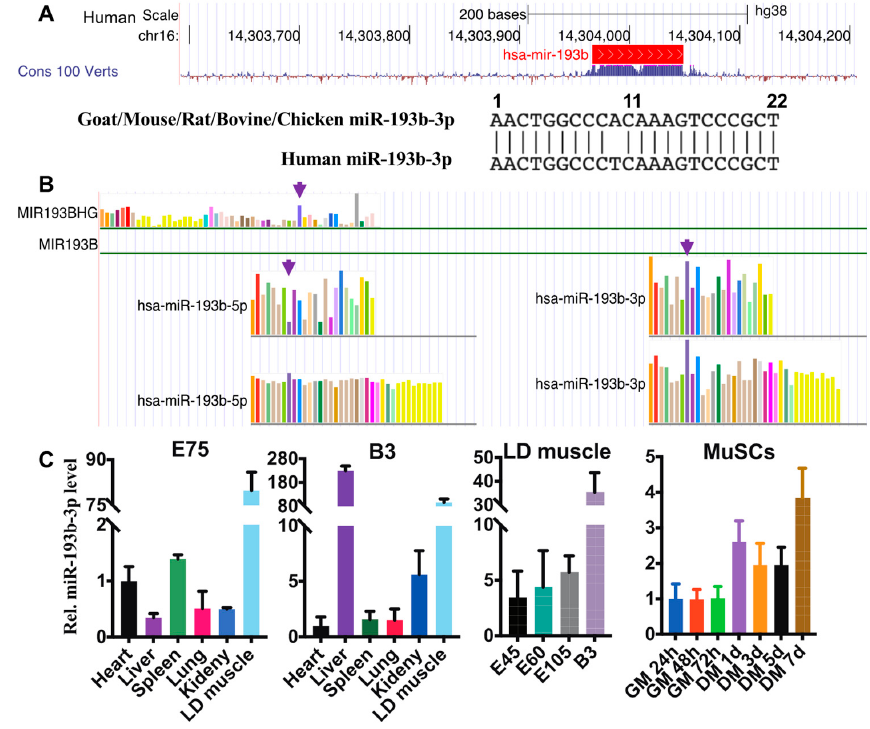
Figure 1. The sequence and expression conservation of miR-193b-3p. ( A ) miR-193b-3p sequence is highly conserved among 100 verts in the UCSC genome browser (upper); the 10th nucleotide of human miR-193b-3p is different from that of other animals (low). ( B ) Expression profiles of human MIR193BHG, miR-193b-5p, and miR-193b-3p in multiple tissues from GTEx. Arrows mark the skel- etal muscle. ( C ) Levels of miR-193b-3p in tissues from embryonic 75 days (E75) and 3 d postnatal (B3) goat kids, or longissimus dorsi (LD) muscle from E45 to B3, as well as in cultured skeletal mus- cle satellite cells (MuSCs). RNA levels are quantified by employing RT-qPCR and calculated by the 2 −ΔΔ Ct methods, with normalization to β -actin (ACTB) and values of the first tissue or timepoint set to 1. Data are shown as mean ± MSE. To address the function of miR-193b-3p in muscle, we first transfected miR-193b-3p mimic (mi-193b-3p, 5 μ g/mL) into goat MuSC cultured in vitro. We found out that com- pared with the control (mi-Ctrl), ectopic miR-193b-3p (~170 foldchange) greatly upregu- lated mRNA levels of proliferation and differentiation myogenic genes, including PAX7, PCNA, MyoG, MyHC, and myomaker (Figure 2A). Furthermore, protein levels of PAX7 and MyoG quantified via western blotting (WB) confirmed their elevation caused by miR- 193b-3p (Figure 2B). Additionally, we employed CCK-8 and EdU assay to monitor the proliferation ability and unveiled that miR-193b-3p mimic transfected for 24 h to 72 h greatly upregulated OD value at 450 nm (Figure 2C), as well as the EdU + cells at 48 h (Figure 2D,E). Moreover, the myotube formation was induced by miR-193b-3p mimic, as shown by the increased size/number of MyHC staining cells at d 7 of differentiation (Fig- ure 2D, right panel). Contrarily, inhibiting miR-193b-3p (in-193b-3p, 100 nmol) downreg- ulated myogenic gene expression by 30~50% ( p > 0.05, Figure 2F,G), compared to the con- trol (in-Ctrl). Consistently, myoblast proliferation and myotube formation were also re- tarded by deficiency of miR-193b-3p, as shown by OD values (Figure 2H), the fold change of EdU + cells, and MyHC staining myotubes (Figure 2I,J). Factors affecting cell viability, including autophagy and apoptosis, also play a critical role in cell proliferation and differentiation [32]. Therefore, we evaluated the mRNA level of the essential autophagy-related gene LC3B (Microtubule Associated Protein 1 Light Chain 3 Beta) [33] and BECN1 (Beclin 1), as well as apoptosis-related Caspase1 [34]. We